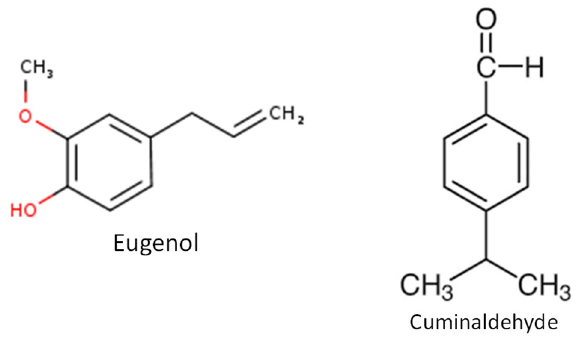
Figure 1. Compounds of Aegle